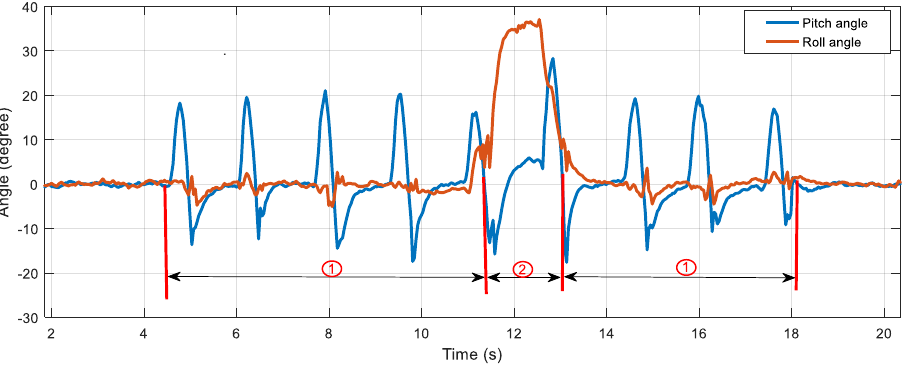
Figure 19. Measurement of abnormal foot attitude.